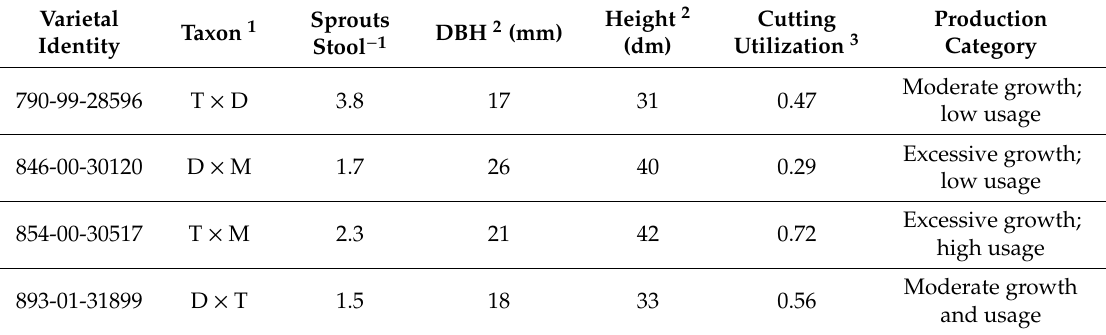
Table 1. Experimental varieties, taxa, and hardwood nursery production